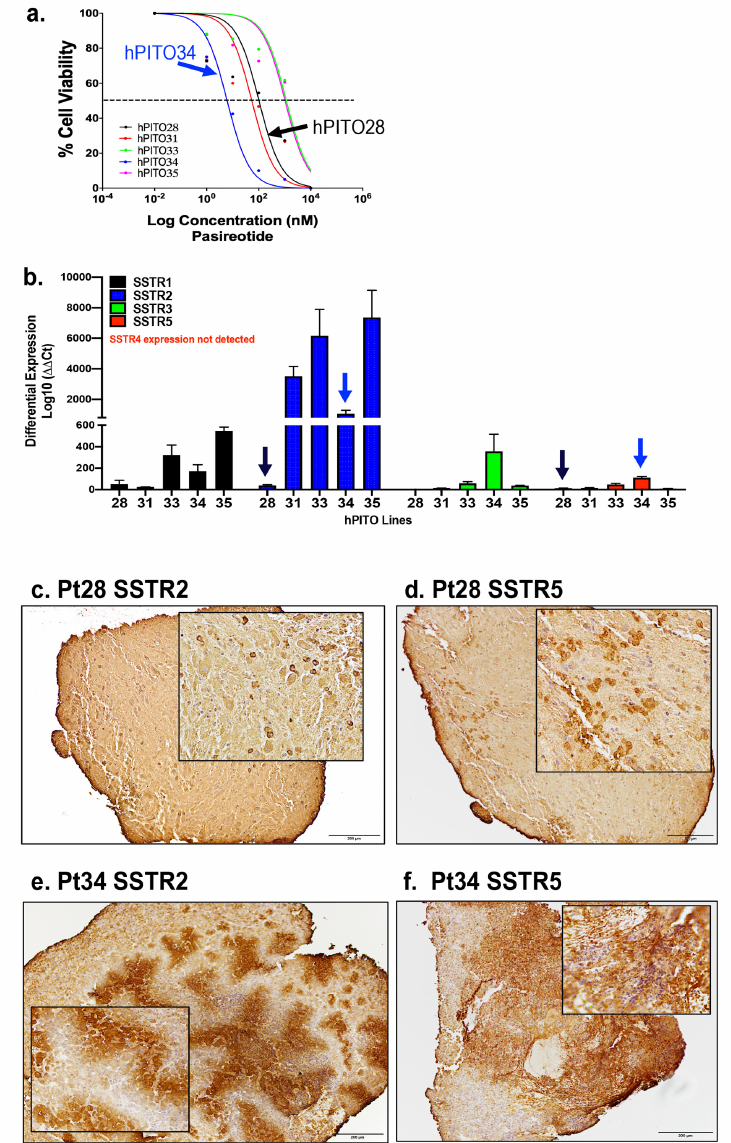
Figure 5. SSTR1-5 expression in hPITOs and patient’s PitNET tissue. ( a ) Dose response of hPITO28, 31, 33, 34, and 35 lines to pasireotide. ( b ) Differential expression of SSTR subtypes 1–5 (SSTR1, SSTR2, SSTR3, SSTR4, SSTR5) in hPITO28, hPITO31, hPITO33, hPITO34, and hPITO35. Immunohistochemistry of ( c , e ) SSTR2 and ( d , f ) SSTR5 expression in patient PitNET tissue (Pt28 and Pt34), from which hPITO28 and 34 were generated.